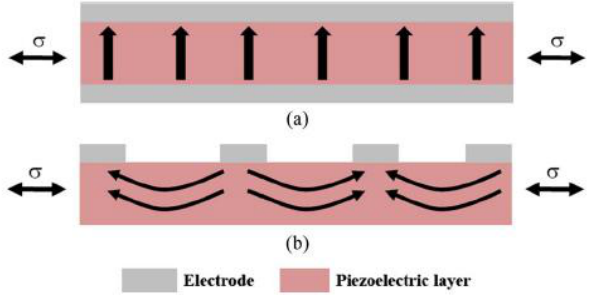
Figure 13. Polarization with d ( © 2013 IEEE. Reprinted with permission from